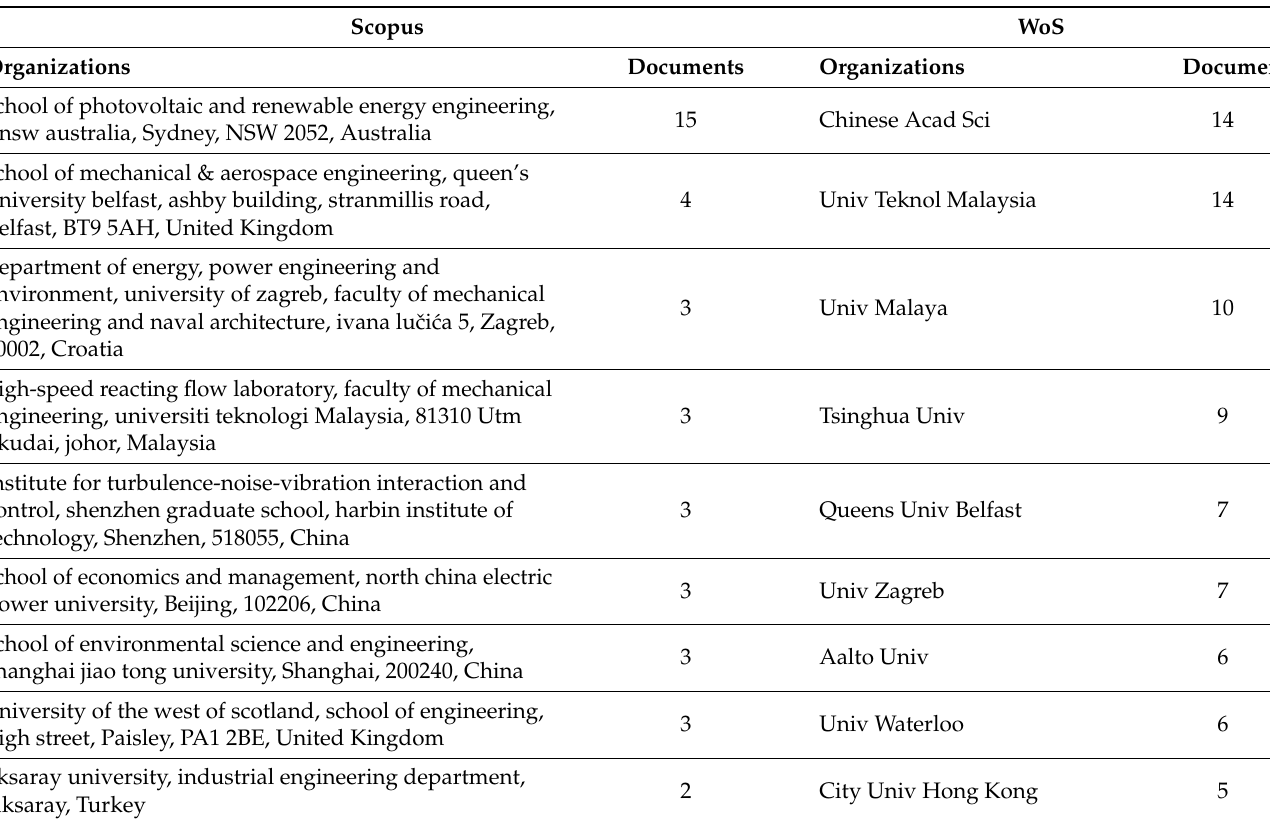
Table 3. Top-20 networked organizations from Scopus and WoS databases for bibliographic coupling links.